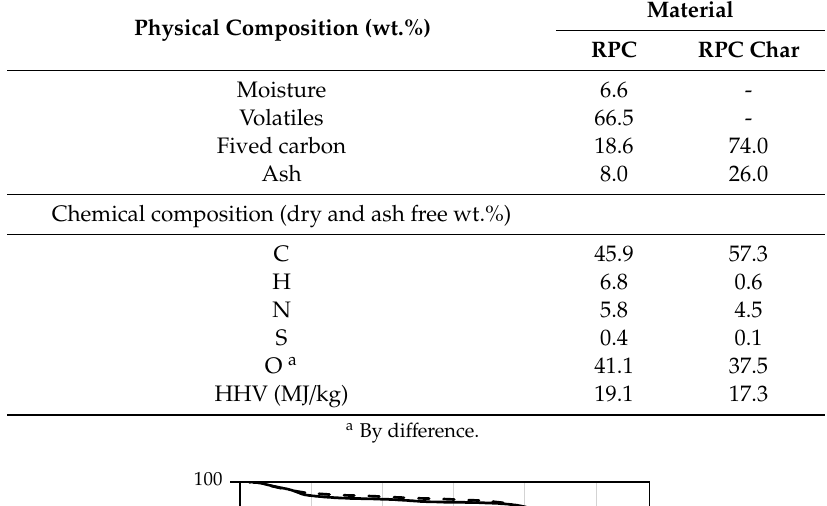
Table 2. Physical and chemical composition of rapeseed oil press cake (RPC) and RPC char (in wt.%). Physical Composition (wt.%)